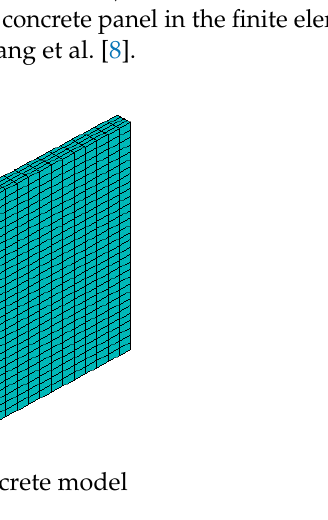
Figure 10. Deformation and force diagrams for RDB.